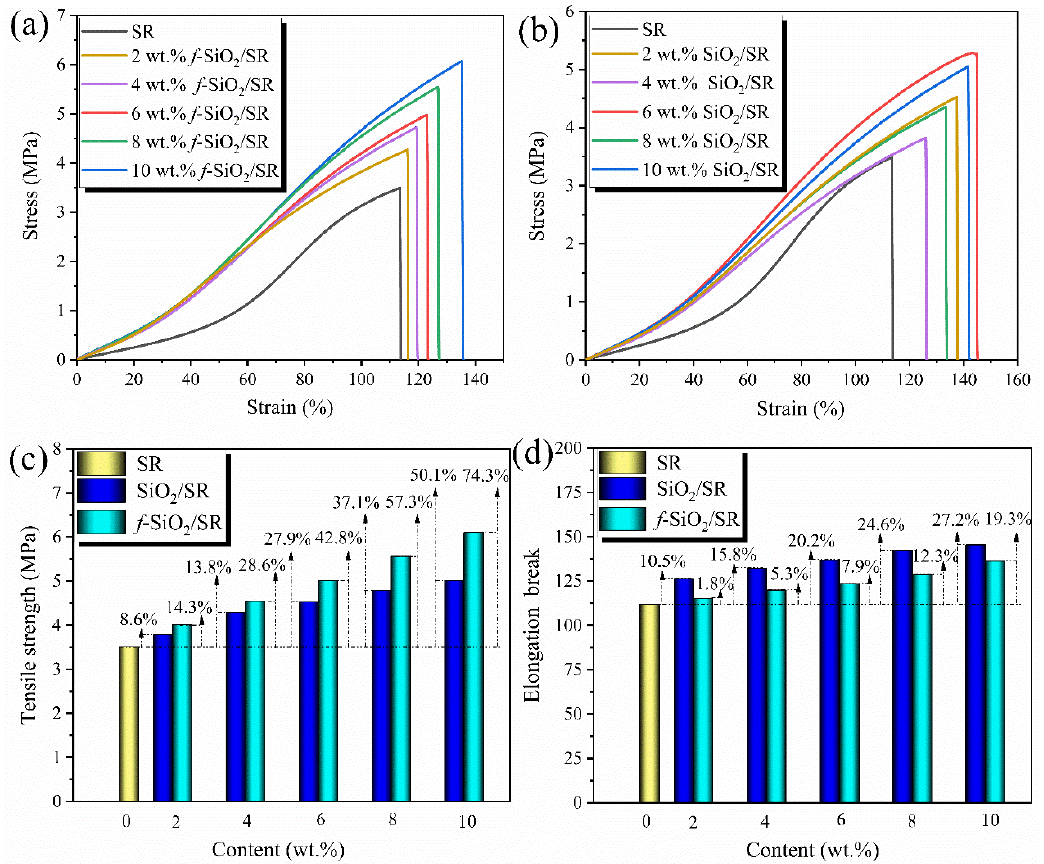
Figure 10. ( a , b ) Tensile stress–strain curves of f -SiO 2 /SR and SiO 2 /SR composites and ( c ) tensile strength of SR and its composites filled with f -SiO 2 and SiO 2 ; ( d ) elongation break of SR and its composites filled with f -SiO 2 and SiO 2 .